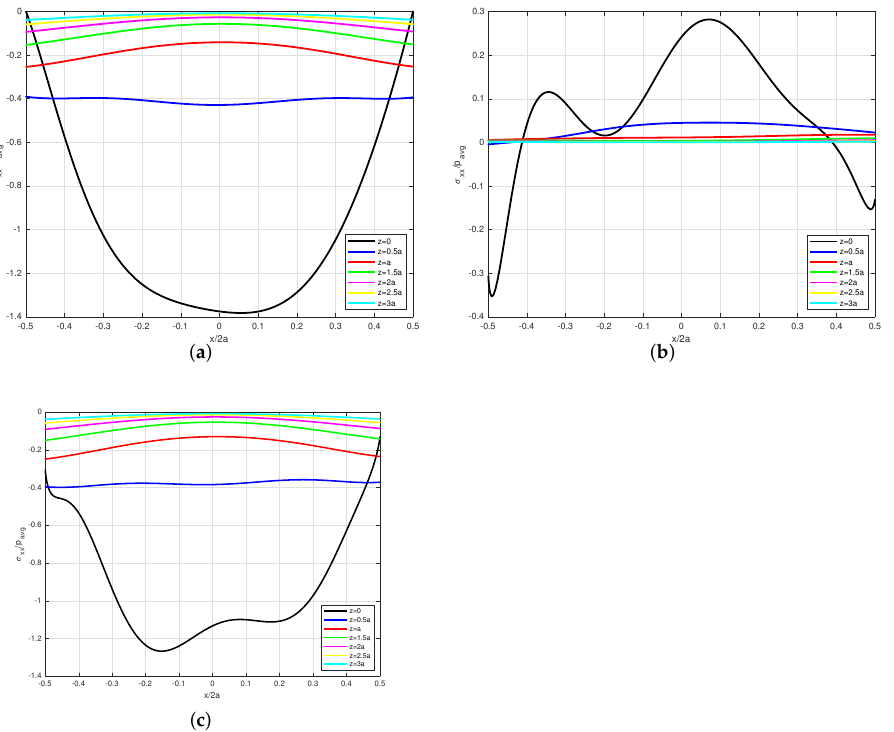
Figure 10. Horizontal stress σ xx at various depths due to ( a ) normal component of boundary traction p ( x (cid:48) ) ; ( b ) tangential component of boundary traction q ( x (cid:48) ) ; ( c ) both p ( x (cid:48) ) and q ( x (cid:48) ) .